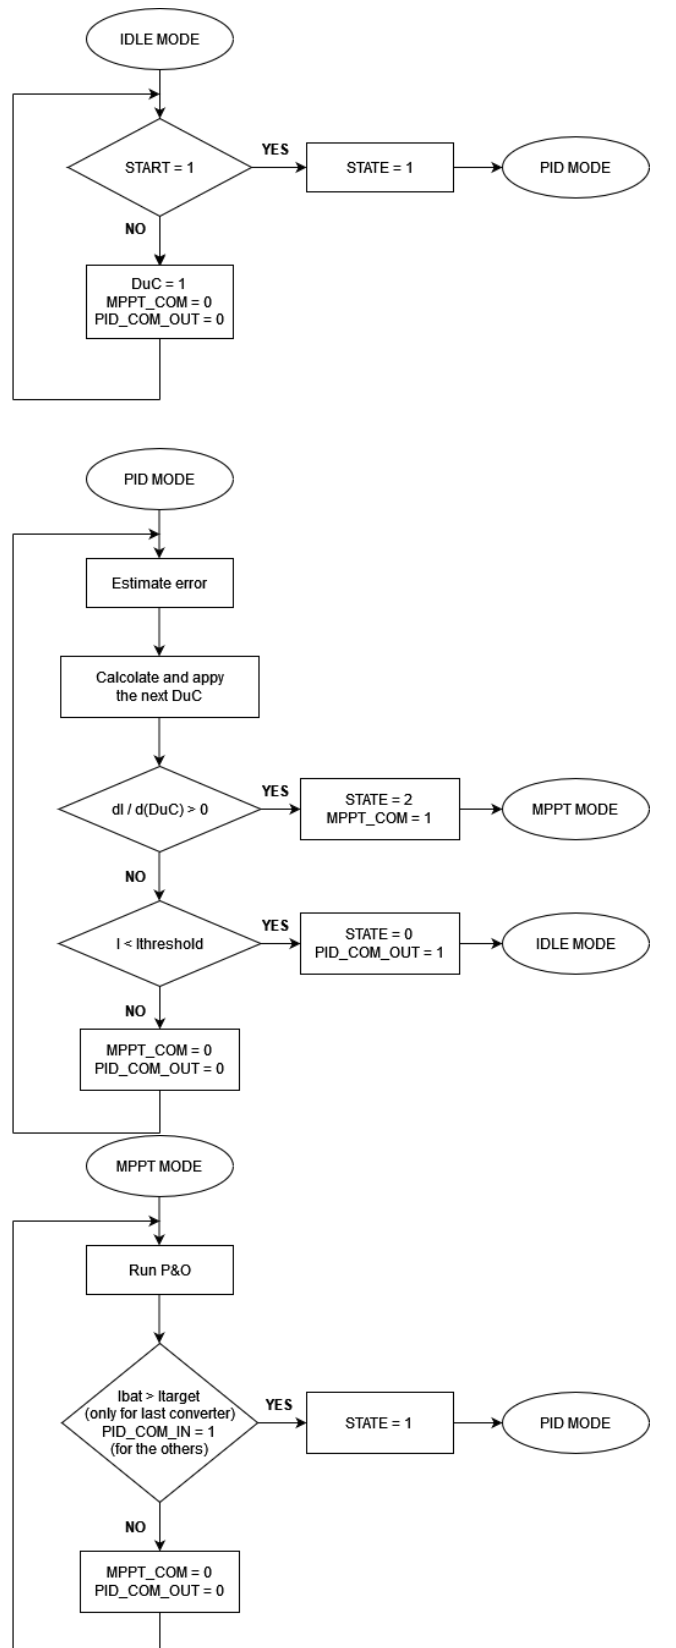
Figure 12. Flow chart of the control algorithm.